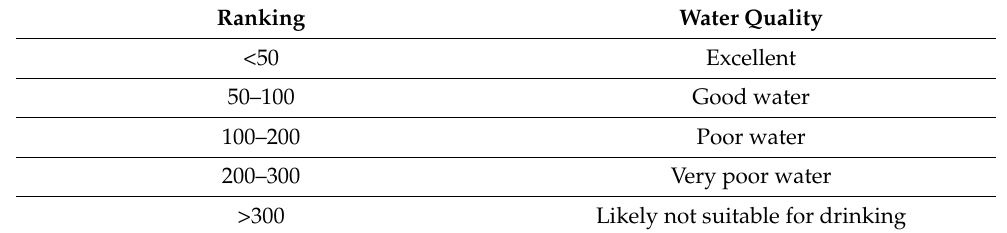
Table 2. Water quality classification based on Water quality Index (WQI) values